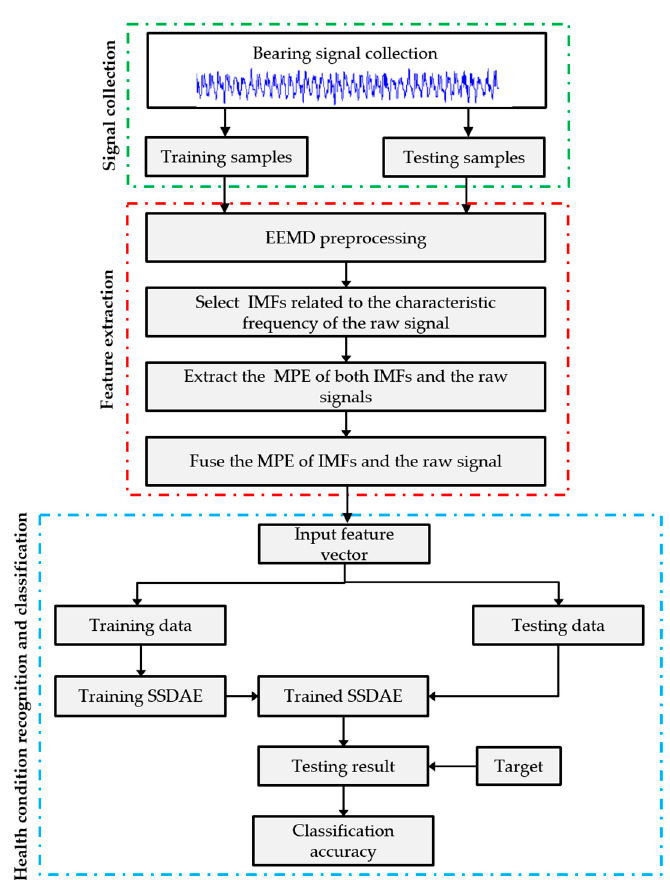
Figure 1. Flow chart of the proposed diagnosis method.